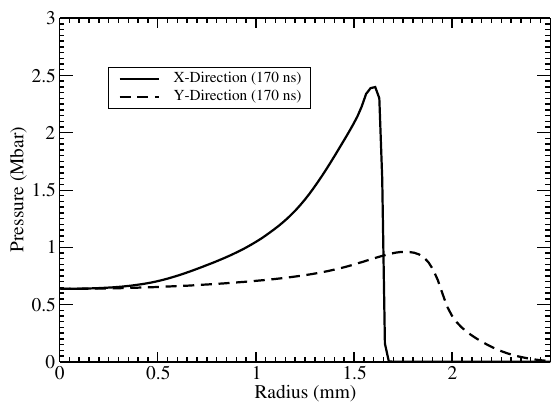
FIG. 22. Same as in Fig. 21, but at t (cid:3) 170 ns .